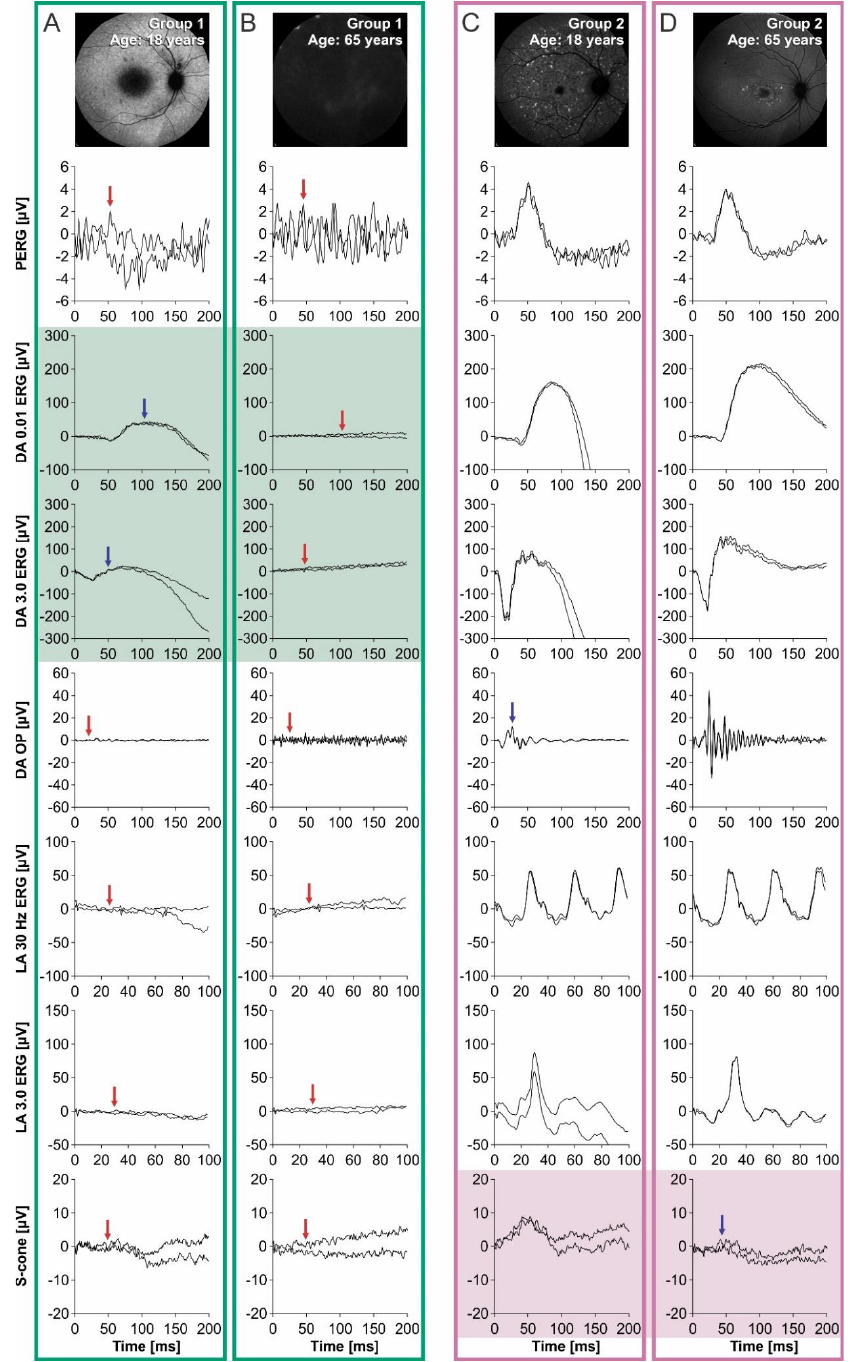
Figure 5. ERG responses from two younger and two older representative patients from each group. Panels ( A , C ) show responses from an 18- and 65-year-old patient from Group 1, while panels ( B , D ) show responses from an 18- and 65-year-old patient from Group 2. Detectable but abnormal responses are marked with blue arrows, while undetectable responses are marked with red arrows. A fundus autofluorescence image of the macula is shown for each patient in the top-right corner. Note that the DA 0.01 ERG b-wave and DA 3.0 ERG a-wave were only detectable in the 18-year-old patient from Group 1 ( A ) and no responses were detectable in the 65-year-old patient from the same group ( D ). In comparison, all responses were detectable in both the 18- and 65-year-old patients from Group 2 (( B ) and ( D ), respectively) with, however, a notable difference in the S-cone